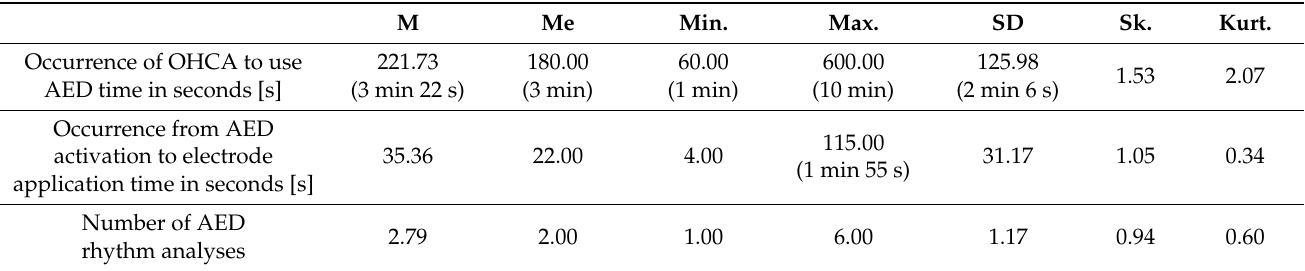
Table 1. Basic descriptive statistics for a number of defibrillations and several rhythm analyses by AED ( n = 33).